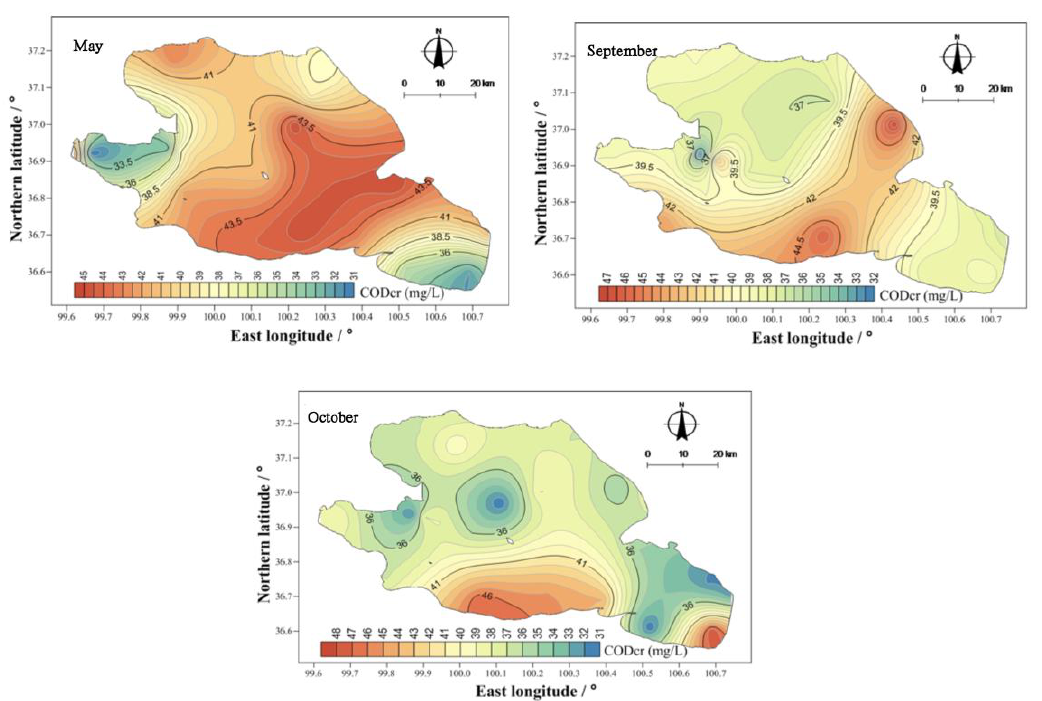
Figure 9. Spatial distribution characteristics of the COD Cr concentrations in Qinghai Lake in different seasons.